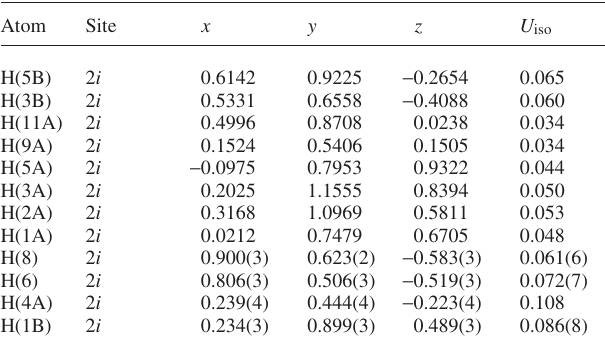
Table 2. Atomic coordinates and displacement parameters (in Å 2 )